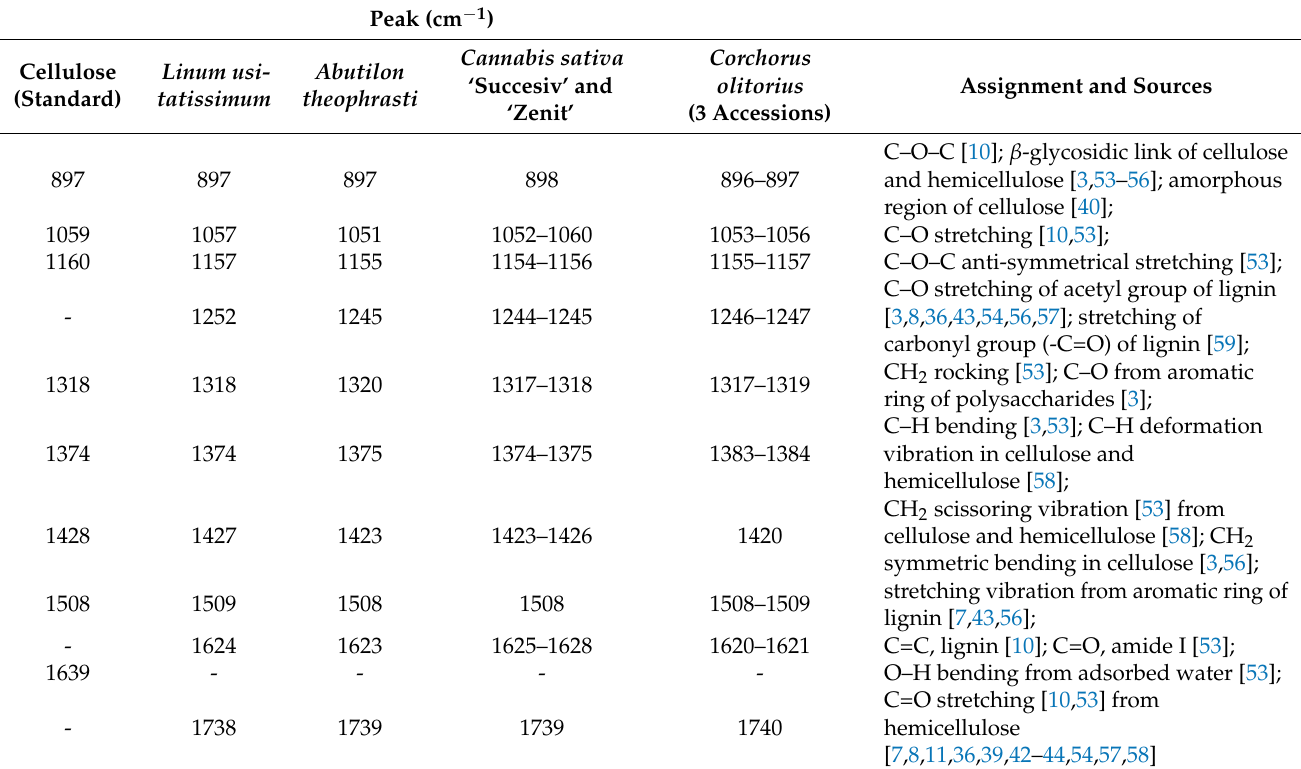
Table 3. Summary of peak positions for FT-IR spectra of stems from four fiber species within region 800–1800 cm − 1